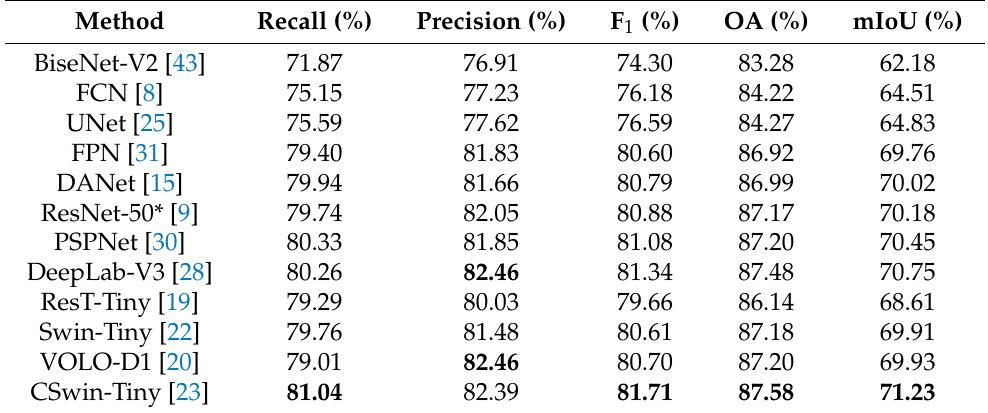
Table 3. Comparison of the CNN and Transformer methods on the Barley Remote Sensing